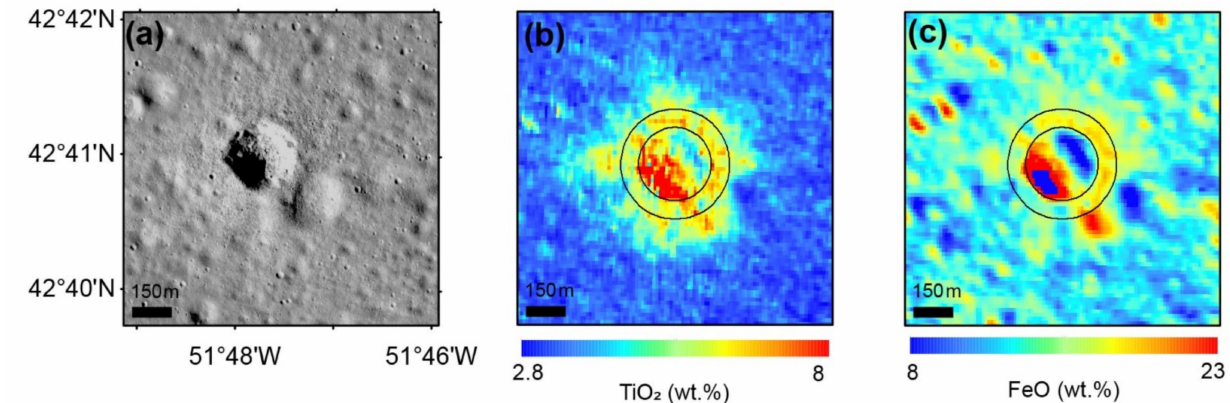
Figure 5. ( a ) LRO NAC image of the crater No. 2 in Table 1. ( b , c ) show the TiO 2 and FeO contents of the same crater. The circles in ( b , c ) represent the extents of 1 and 1.5 radii from the crater center, where the FeO and TiO 2 contents of the pixels are